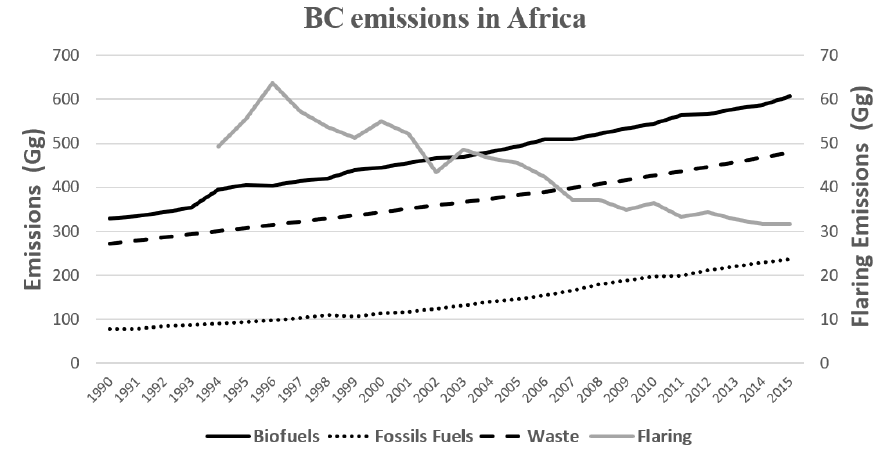
Figure 1. Time series of BC emissions in Africa for fossils fuels, biofuels, open waste burning and